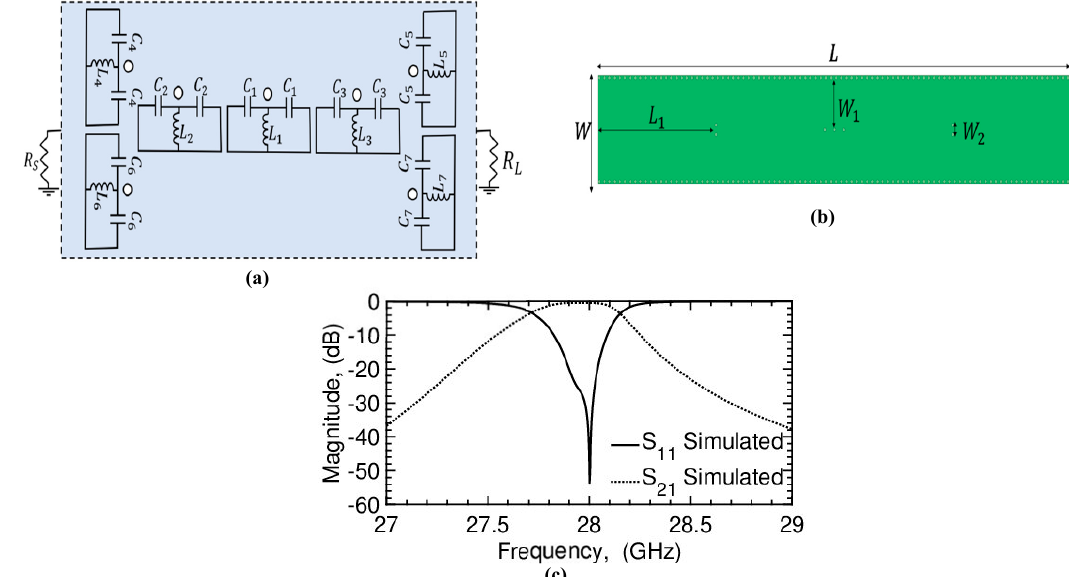
Figure 6. Simulated 28 GHz band Rogers 5880 filter. ( a ) Equivalent circuit for 28 GHz filter. Each via corresponds to an LC four-terminal element. R S and R L , equivalent resistance of source and load. ( b ) Schematic of proposed filter: W = 4.54 mm, W 1 = 2.19 mm, W 2 = 0.24 mm, L = 27.55 mm, and L 1 = 6.8875 mm. ( c ) Simulated S-parameters.